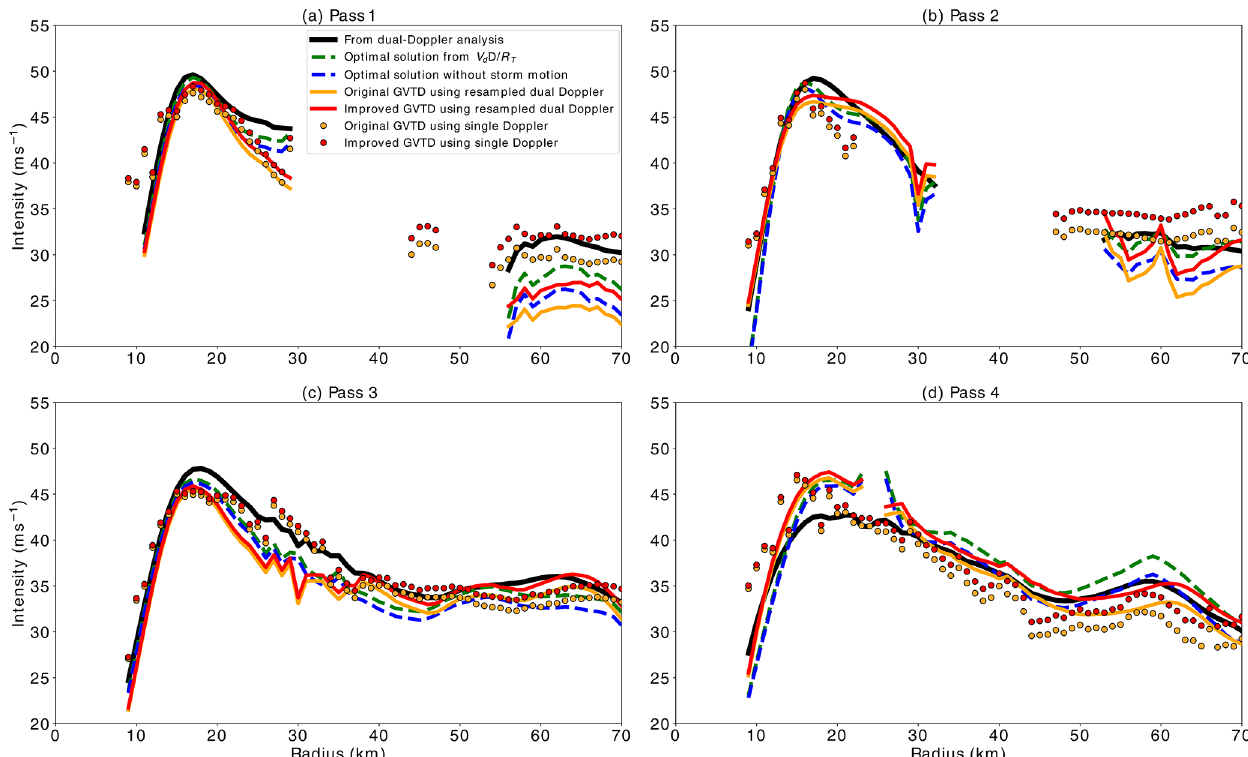
Figure 4. Wave number 0 tangential wind retrieved by various techniques at (a) pass 1 from 18:55 to 19:40UTC, (b) pass 2 from 20:20 to 21:05UTC, (c) pass 3 from 21:45 to 22:30UTC, and (d) pass 4 from 23:05 to 23:40UTC. The retrievals are the Fourier decomposition of tangential wind from the dual-Doppler analysis (black line), the Fourier decomposition of V d D/R T (green dashed line), the Fourier decomposition of V d D/R T without storm motion (blue dashed line), the original GVTD algorithm (orange line) and improved GVTD algorithm (red line) from the resampled dual-Doppler analysis, and the original GVTD algorithm (orange dot) and improved GVTD algorithm (red dot) from the single-Doppler